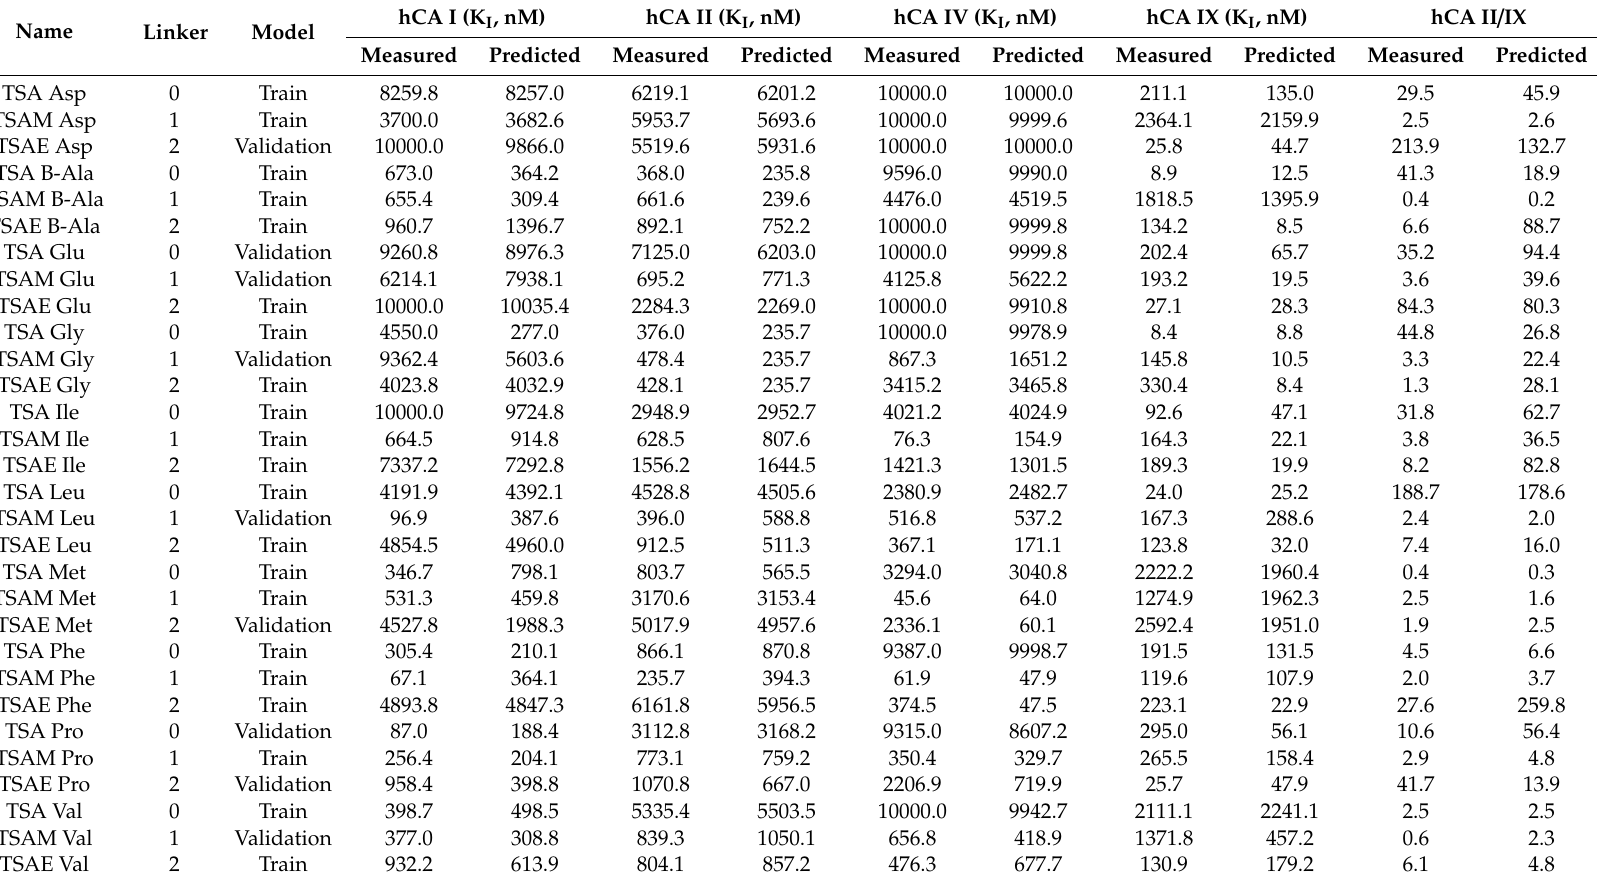
Table 3. Comparison of measured and predicted inhibitory values for sulfonamide derivatives with a symmetric pair of amino